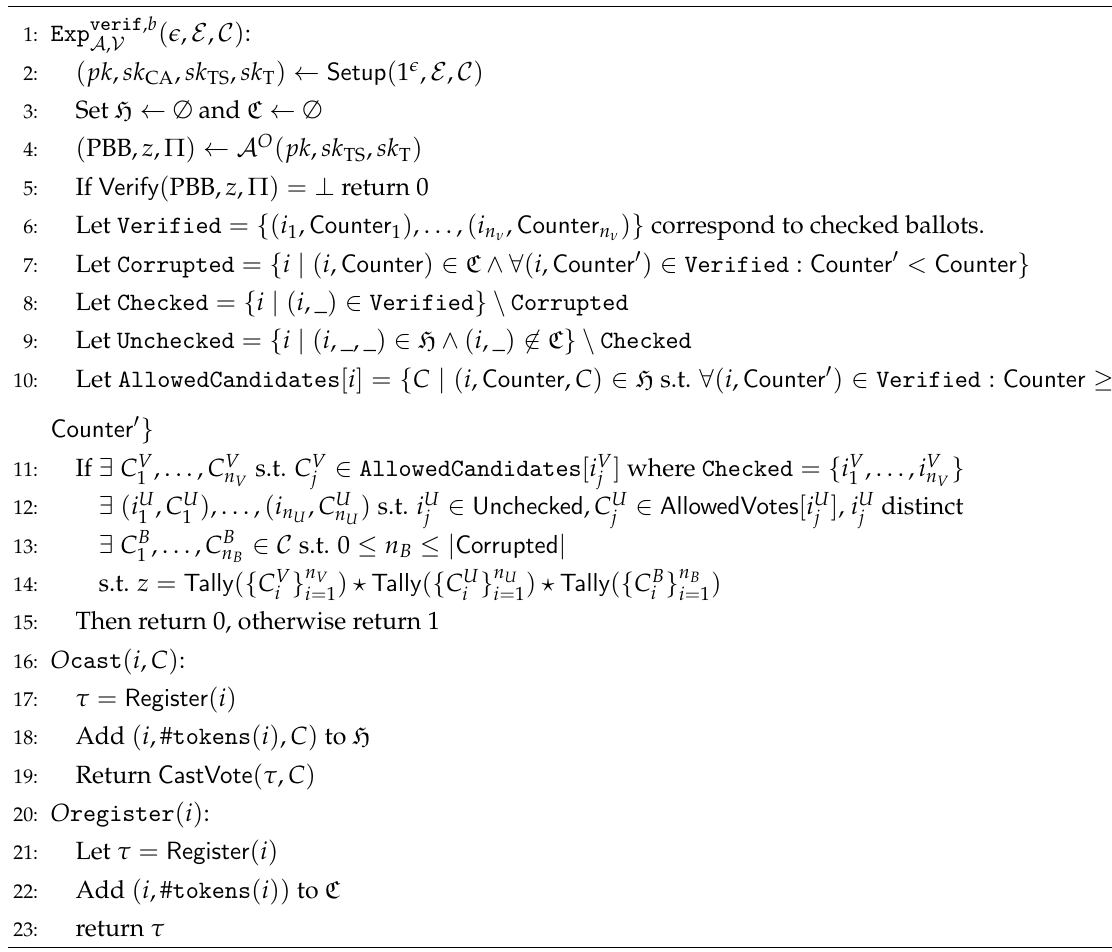
Algorithm 3 Verifiability game presented by Lueks et al. [29]. In the verifiability game